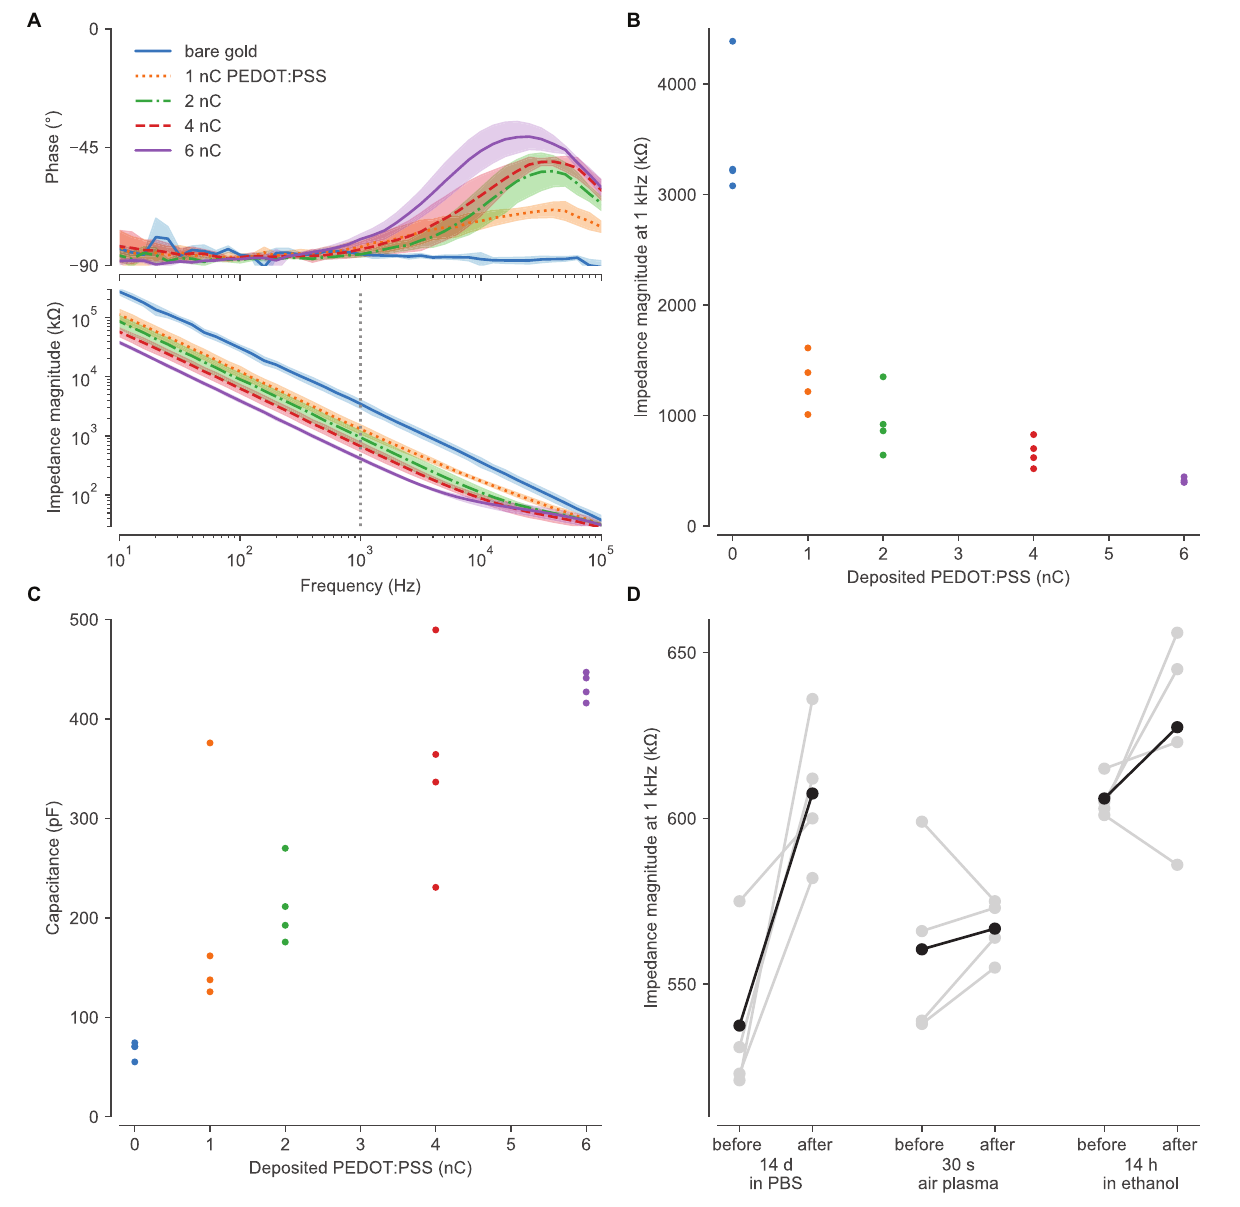
FIGURE 2 | Electrochemical characterization. (A) Coating with PEDOT:PSS decreased the electrochemical impedance. Measurements of impedance of bare gold ultramicroelectrodes were compromised by the shunt capacitance of the insulator. (B) Increasing PEDOT:PSS deposition reduced impedance at the key frequency of 1 kHz. (C) Equivalent capacitances were fitted over the frequency range most relevant for extracellular electrophysiology (1–5000 Hz), where the electrodes had predominantly capacitive behavior with phase near − 90 ◦ . (D) PEDOT:PSS coatings survived soaking in PBS at 37 ◦ C, exposure to air plasma, and ethanol disinfection. Degradation or removal of PEDOT:PSS would have reverted the electrodes to the value of several M (cid:127) impedances (at 1 kHz) of the uncoated electrodes. Points in B and C indicate values from individual electrodes. Gray points in D indicate paired measurements for single electrodes; black points are averages as a visual